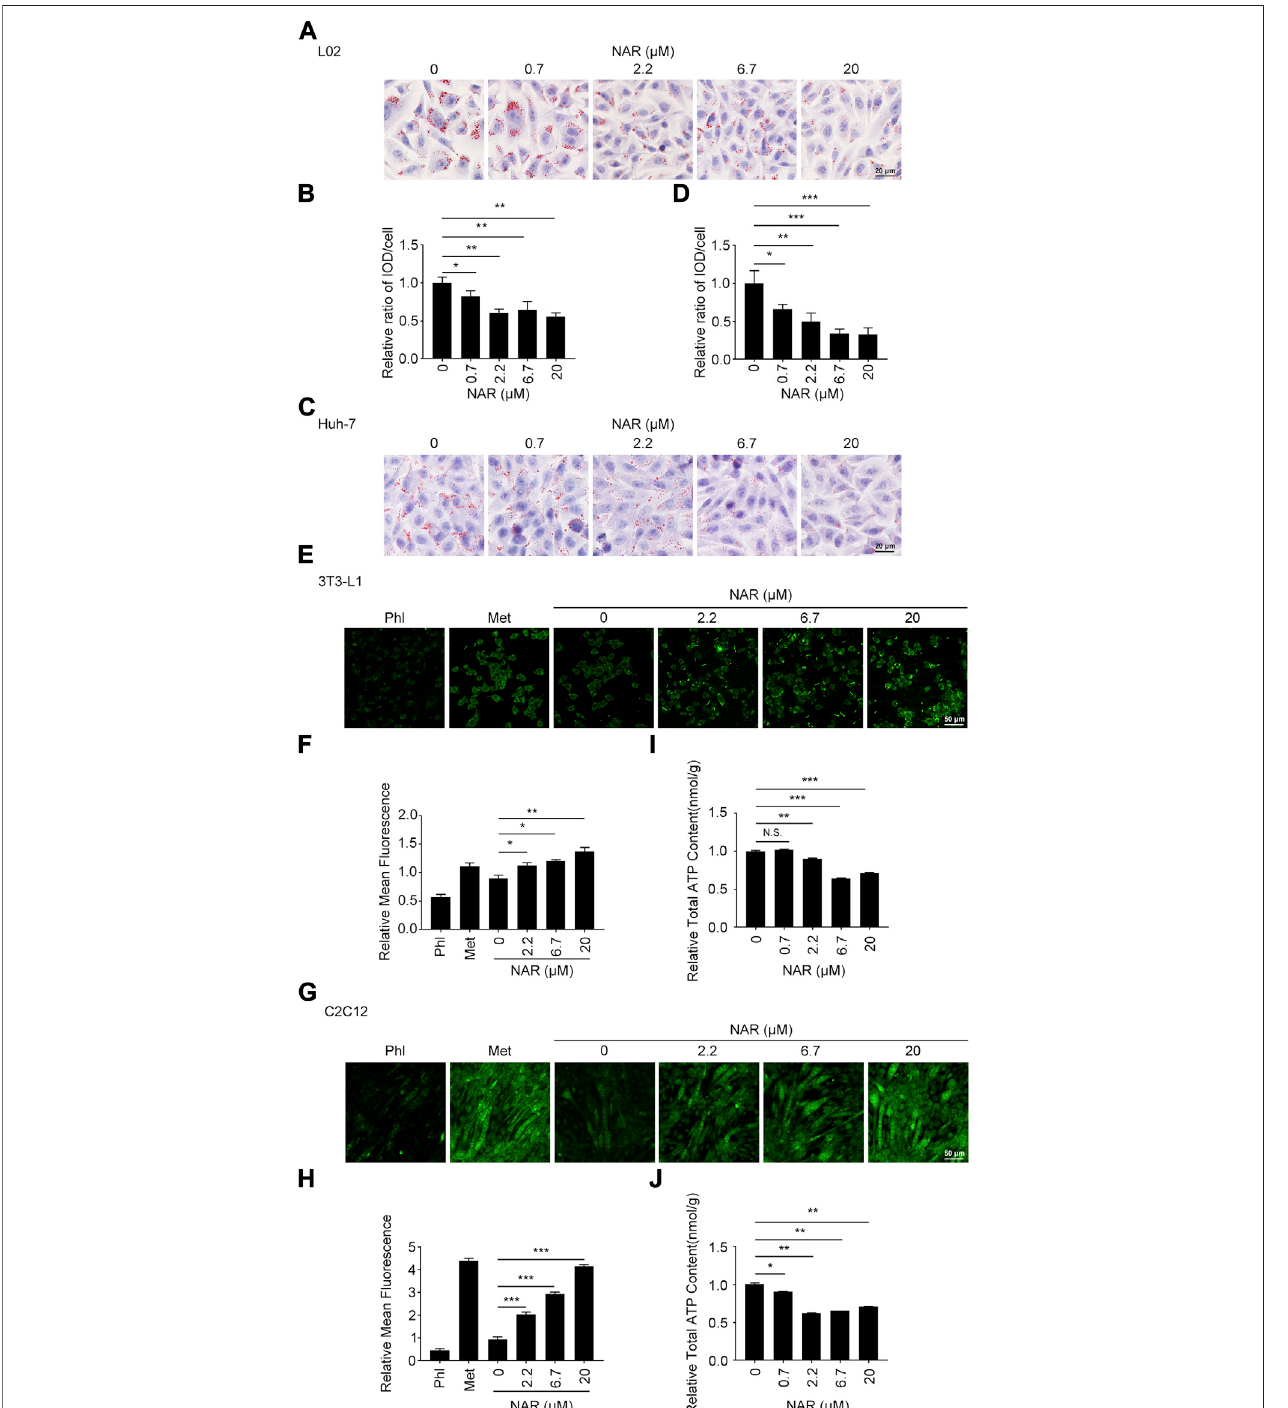
FIGURE2| NARalleviateslipidaccumulationinL02andHuh-7cells,enhancesglucoseuptake,anddecreasestheATPcontentin3T3-L1adipocytesandC2C12 myotubes. Sodium oleate-induced L02. (A,B) and Huh-7 cells (C,D) were treated with NAR (0, 0.7, 2.2, 6.7, and 20 μ M) for 24 h. Lipid accumulation was visualized using oil red O staining (the objective ampli fi cation 20 × ). 3T3-L1 adipocytes (E,F) and C2C12 myotubes (G,H) were treated with NAR (0, 2.2, 6.7, and 20 μ M), phloretin (100 μ M), or metformin (2.5 mM) for 4 h. Glucose uptake was detected by 2-NBDG staining and photographed by fl uorescence microscopy (the objective ampli fi cation10 × ).TheATPcontentof3T3-L1adipocytes (I) andC2C12myotubes (J) wasdeterminedusinganATPcalorimetricassaykit.Barsrepresent20 μ M (A,C) , 50 μ M (E,G) . All values were expressed as the mean ± SD from three or more independent experiments. *** p < 0.001; ** p < 0.01; * p < 0.05 vs . untreated cells. Abbreviation: NAR, naringenin; Phl, phloretin; Met, metformin; 2-NBDG, 2-[N-(7-nitrobenz-2-oxa-1,3-diazol-4-yl) amino]-2-deoxy-glucose.